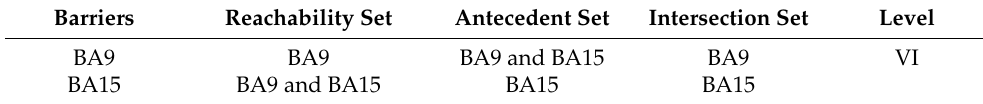
Table 13. Level V partition of the hierarchical structure of the barriers using a final reachability matrix. Barriers Reachability Set Antecedent Set Intersection Set Level BA7 BA7 BA7 and BA15 BA7 BA8, BA9 BA9 and BA15